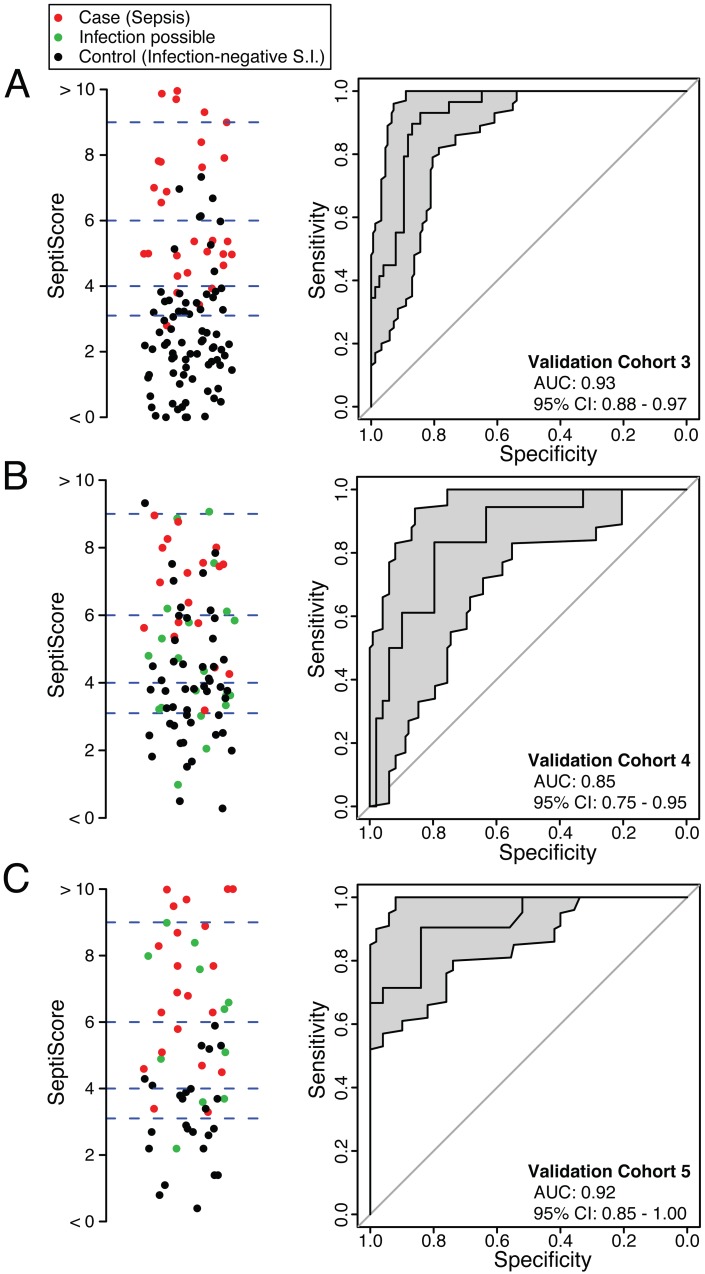
Performance of SeptiCyte Lab in validation cohorts 3, 4, and 5.In each panel, the left side presents a scatterplot of SeptiCyte Lab scores for cases (sepsis; red), controls (infection-negative systemic inflammation [S.I.]; black), and individuals with an infection likelihood of possible (green), and the right side presents the corresponding ROC curve. In the scatterplots, the blue dashed lines denote SeptiScore values of 3.1, 4.0, 6.0, and 9.0, which are used for subsequent calculations. On the right, the grey shading denotes the 95% confidence area for the ROC curve. Patients with an infection likelihood of possible have been excluded from the calculation of ROC curves. (A) Validation cohort 3 (29 cases, 77 controls). (B) Validation cohort 4 (20 cases, 47 controls), consisting of patients sequentially admitted to the ICU. (C) Validation cohort 5 (21 cases, 25 controls), consisting of black and Asian patients sequentially admitted to the ICU.